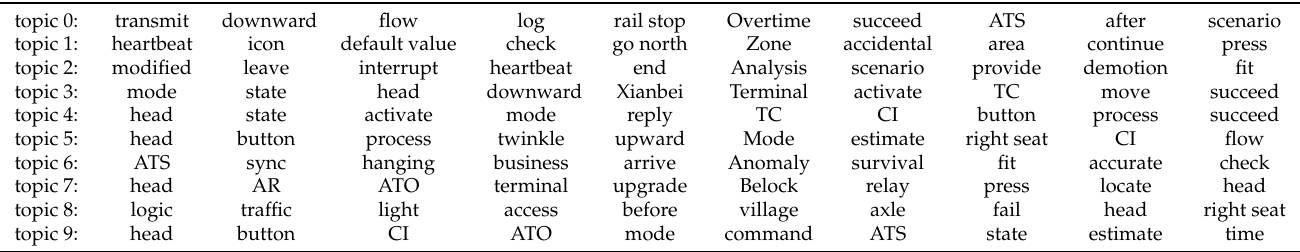
Table 6. Topic analysis of automatic turn-back